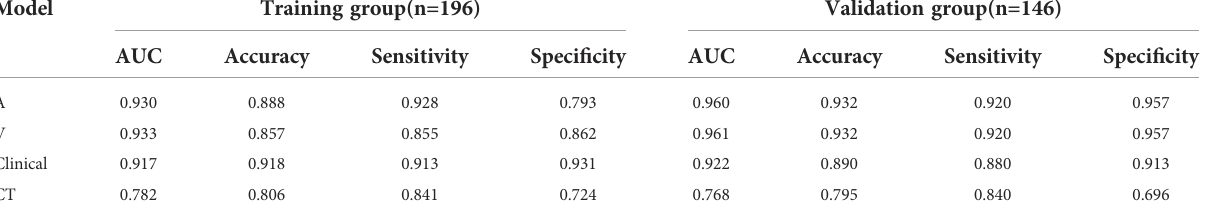
TABLE 4 Effectiveness of radiomics models in the grading of GIST